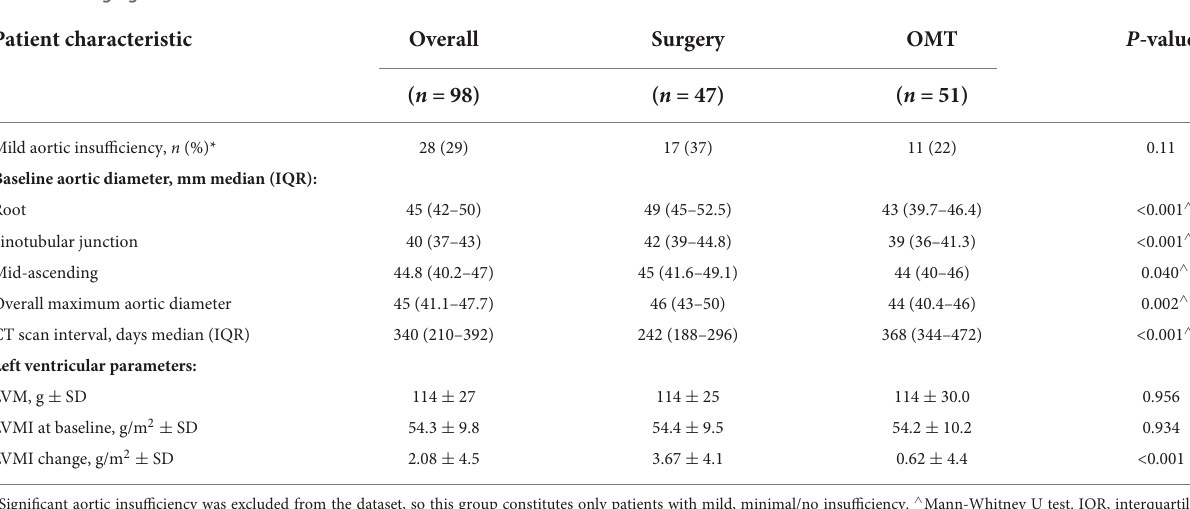
TABLE 2 Imaging characteristics.